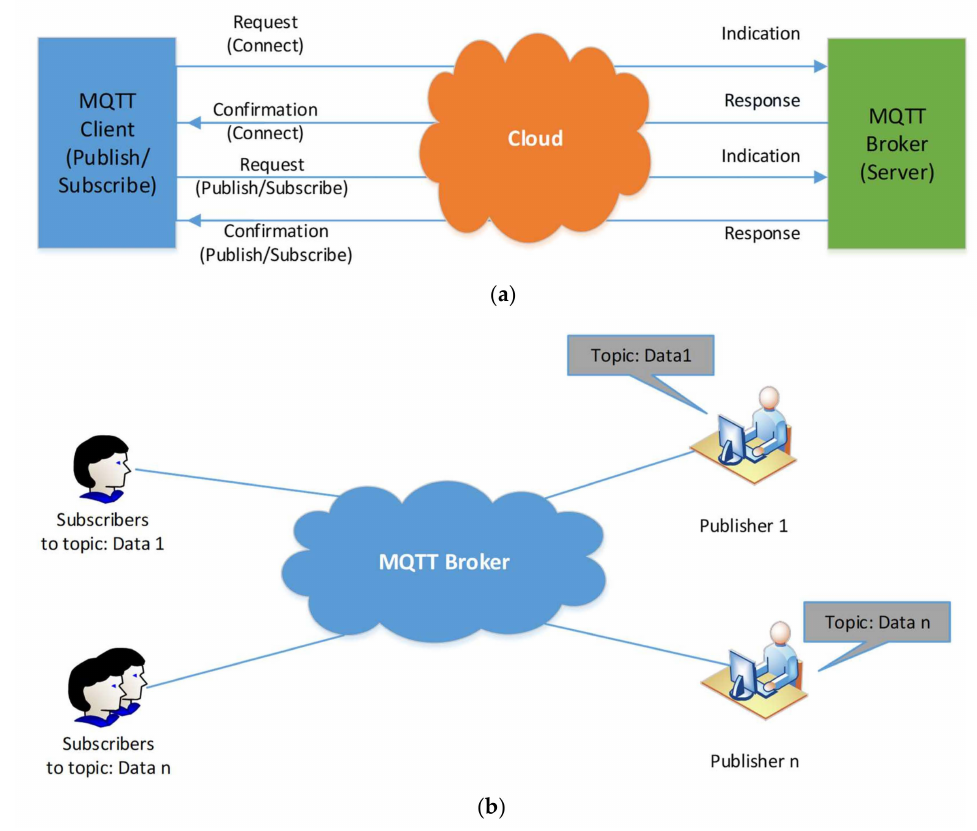
Figure 4. ( a ) MQTT Procedure, ( b ) MQTT Topic and